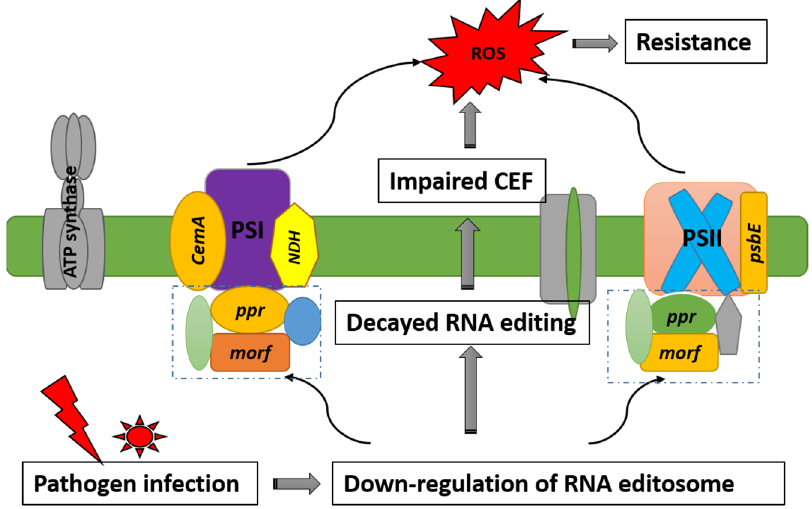
Figure 8. Schematic model for the role of MORF genes in plant immunity. The MORF-regulated ROS burst is likely achieved through its effect on the functionality of respiratory chain components. MORF genes participate in the RNA editing of chloroplast photosystem genes and subsequently affect the cyclic electron flow activities. Pathogen infection leads to down-regulation of MORF genes and reduced RNA editing efficiency, thereby impairing CEF, and up-regulating ROS levels, which enhances the immunity to pathogens.